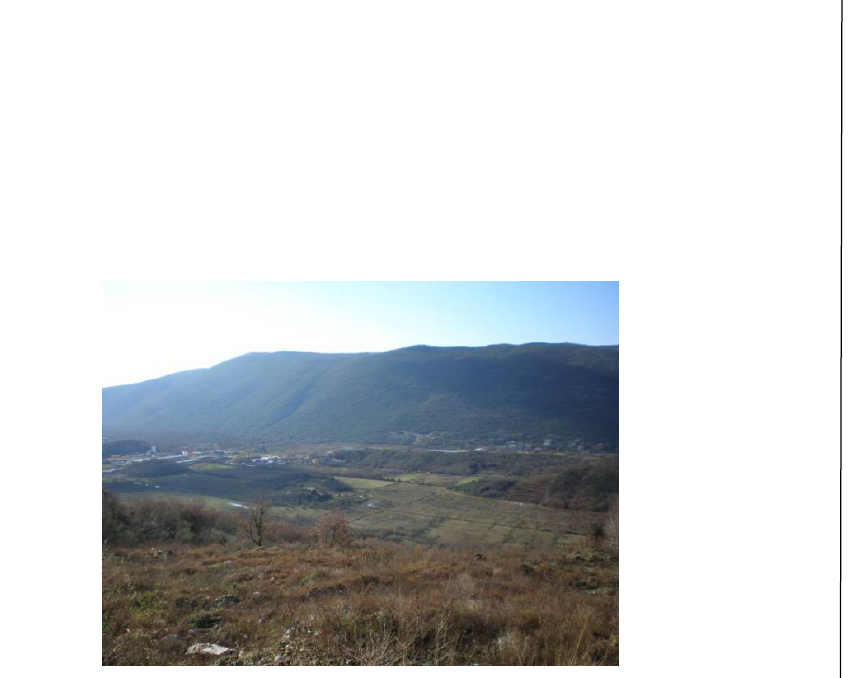
Рис . 5 – Ластва Грбальска , местность под строительство станции